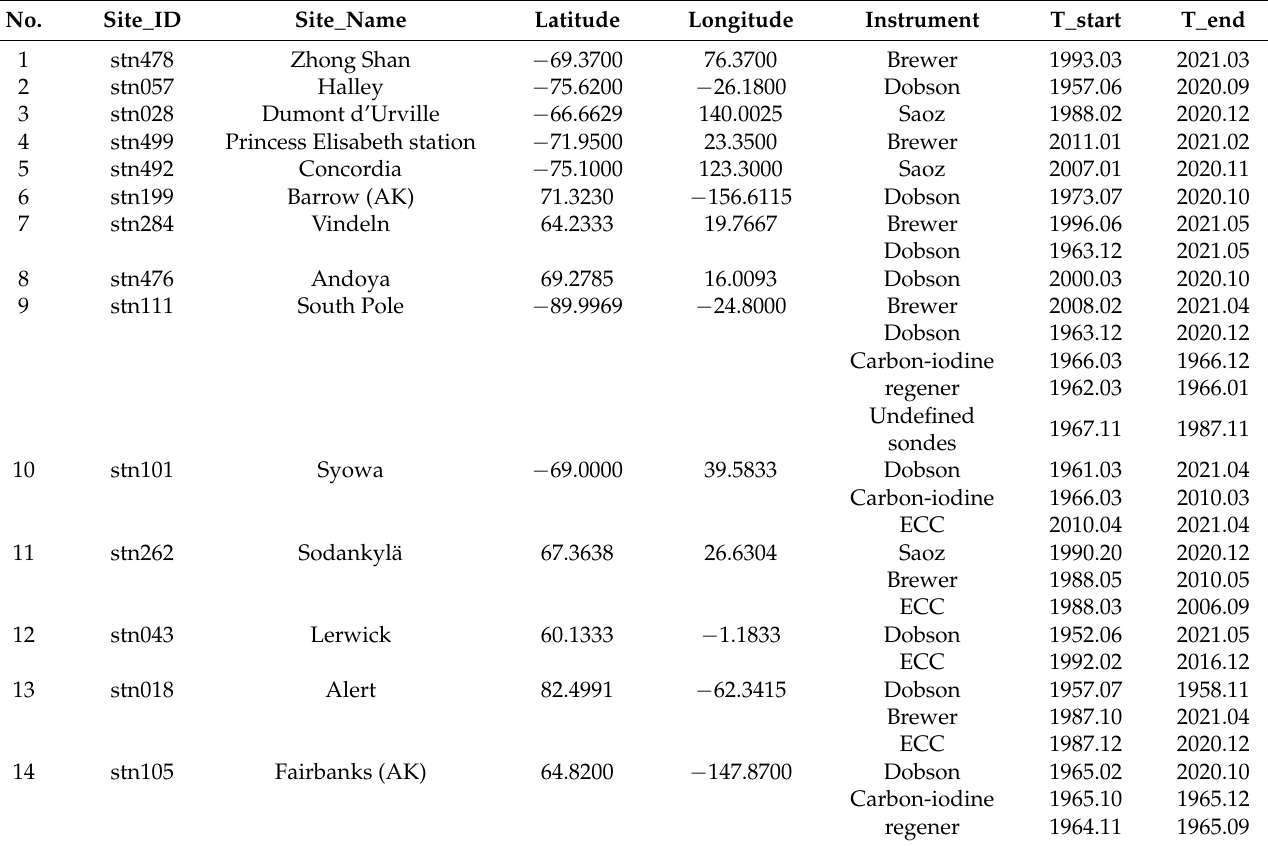
( a ) ( b ) Figure 1. The location of ground-based ozone observation instruments at high latitudes with the background of ERA5 total column ozone. ( a ) Northern hemisphere in March 2020; ( b ) Southern hemisphere in September 2020. Filled circles: Dobson or Brewer stations; asterisks: ozonesonde stations. Table 1. Information on ground-based stations for ozone detection.